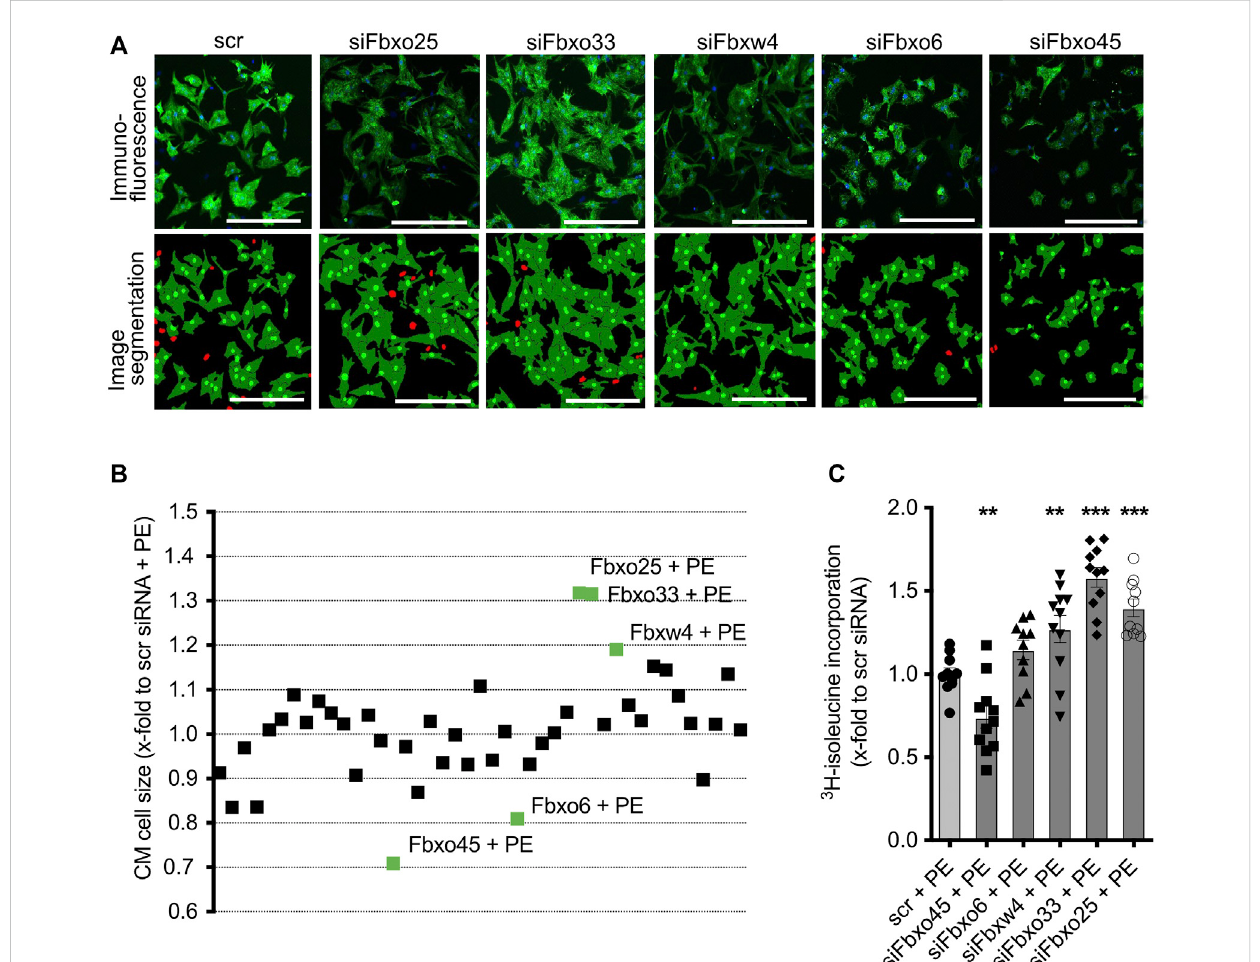
FIGURE 3 Effect of transfected siRNAs on CM at PE-induced CM hypertrophy. (A) Representative immunostainings and image segmentations of neonatal rat cardiomyocytes (CM) upon transfection with scramble control or siRNAs against Fbxo25, Fbxo33, Fbxw4, Fbxo6, and Fbxo45. CM were identi fi ed by staining for α -actinin (green) and nuclei are labelled with DAPI (blue) in immuno fl uorescence pictures. Non-CM are labelled red in image segmentations. Scalebar=500 μ m. (B) EffectoftransfectedsiRNAsonCMsizeuponPE-inducedCMhypertrophy.DataarenormalizedtoscramblecontrolwithPE. Three independentexperiments with > 50,000 cells per group. Statistical signi fi cance between the screening targets was analyzed by 1-way ANOVA and Bonferroni posthoc test. The labelled screening hitsare highly signi fi cant (labelled in green). (C) Validation of cell size change after siRNA transfection on CM by 3 H- isoleucine incorporation with PE-induced hypertrophy. Data are normalized to scramble control with PE (scr + PE). Dots depict cumulative data from three independent cell preparations. Three independent experiments: N = 3, n = 10 – 11. Statistical signi fi cance between the screening targets was analyzed by 1-way ANOVA and Bonferroni post hoc